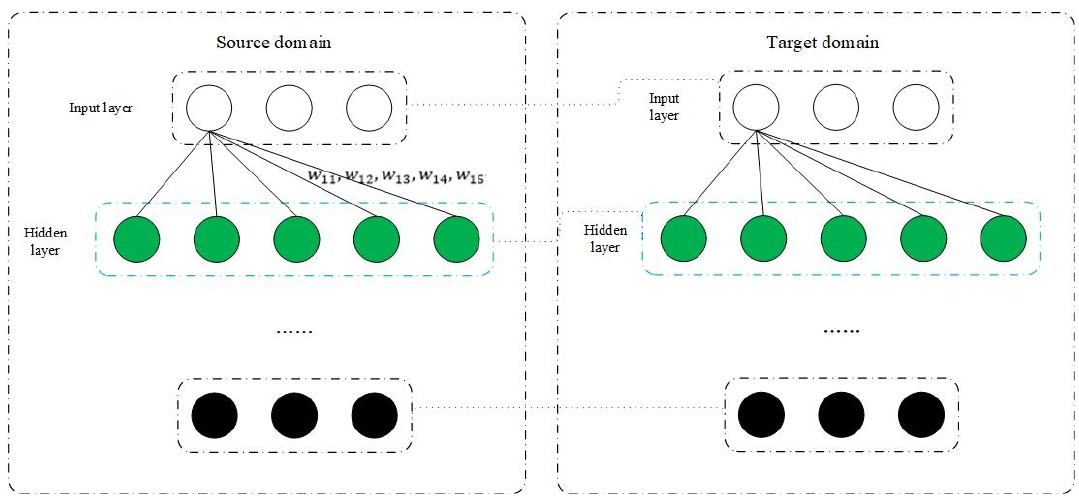
Figure 2. TS1 Transfer both structure and weights of network simultaneously.